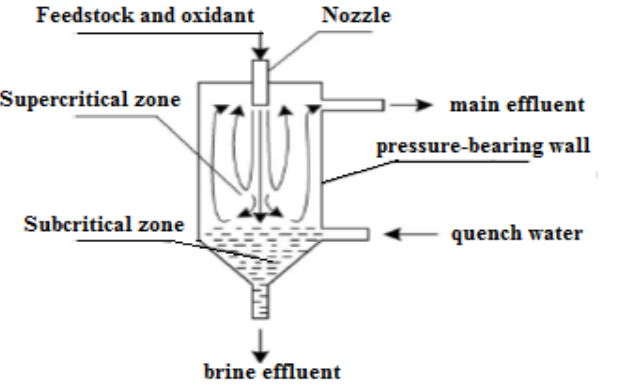
Figure 16. Reverse flow tank reactor [90].